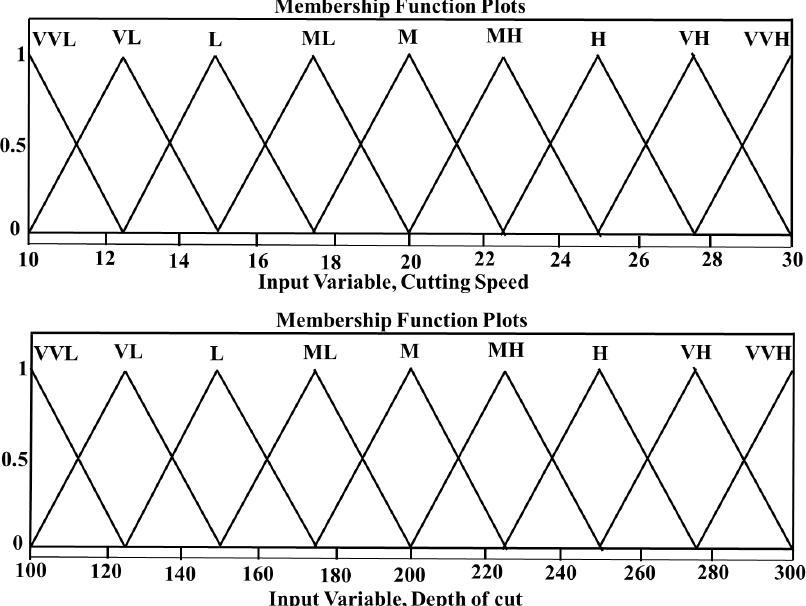
Figure 2. Input variables with associated membership functions used in the simulation of UVAT and CT.